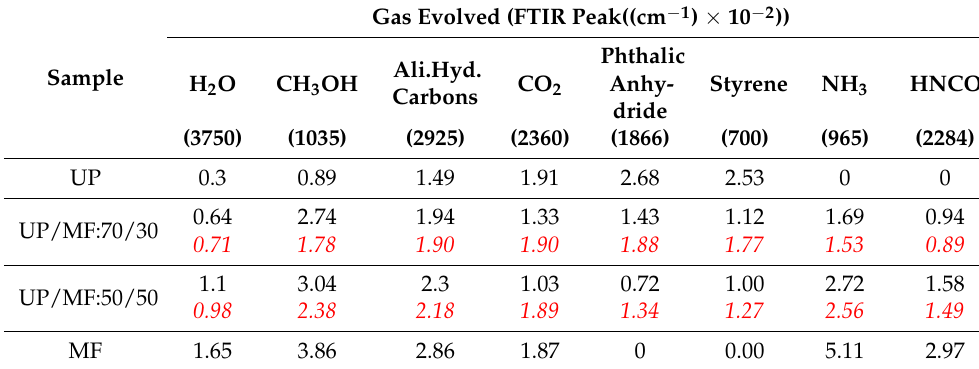
Table 5. Quantities of evolved gases calculated from TGA-FTIR spectra of UP, MF, and their blends in nitrogen.